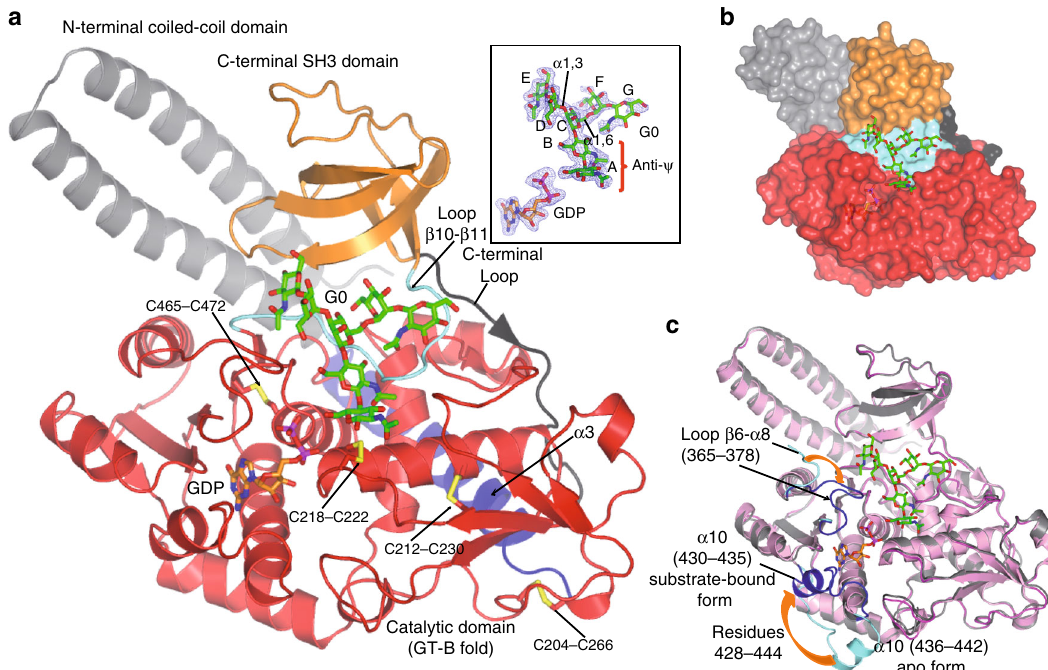
Fig. 4 Overall structure of Hs FUT8 complexed to GDP and G0. a Ribbon structure of Hs FUT8 with GDP (orange carbon atoms) and G0 (green carbon atoms). The coiled-coil, catalytic and SH3 domains are colored in gray, red and orange, respectively. The interdomain α 3 and loop β 10 – β 11 are colored in blue and aquamarine, respectively. Disul fi de bridges are indicated as yellow sulfur atoms. The C -terminal loop is colored in black. (inset) Electron density maps are F O – F C (blue) contoured at 2.2 σ for GDP and G0 . The labels of the sugar units ( A – G ) are also shown. b Surface representation of the Hs FUT8- GDP- G0 complex. c Superposition of Hs FUT8 apo (pink) and substrate-bound (gray) forms. This fi gure also depicts the conformational changes visualized in residues 365 – 378 and 428 – 444. These regions are represented as aquamarine (apo form) and blue (substrate-bound form).